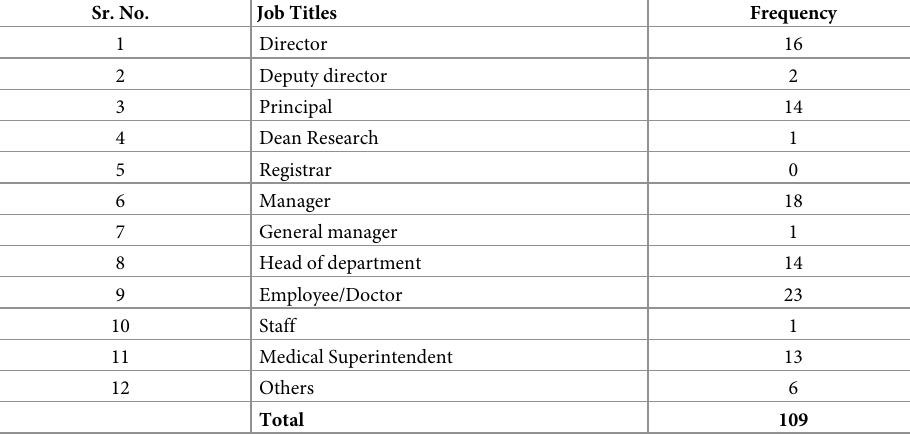
Table 1. Details of the respondents of survey questionnaire. Sr.